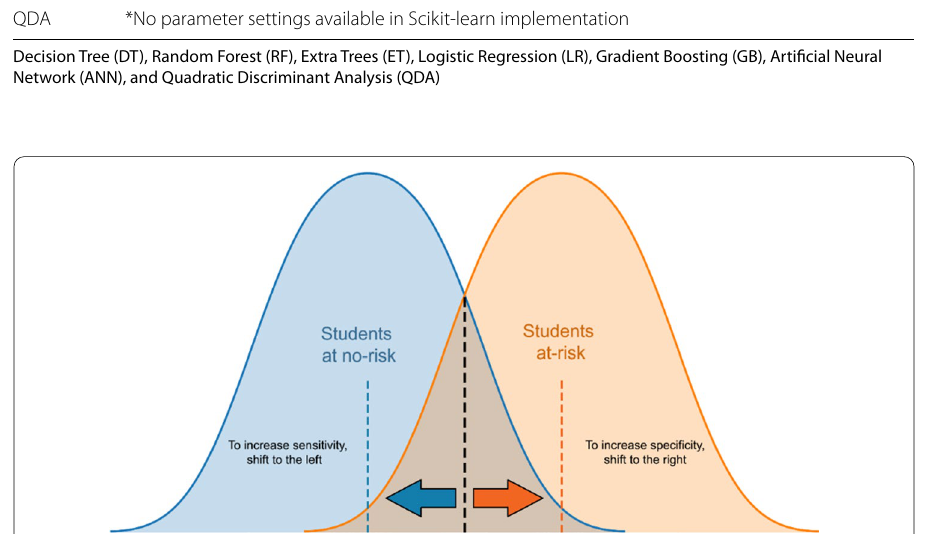
Optimization algorithm [’newton-cg’, ’lbfgs’, ’liblinear’, ’sag’, ’saga’] & Inverse of regularization = strength